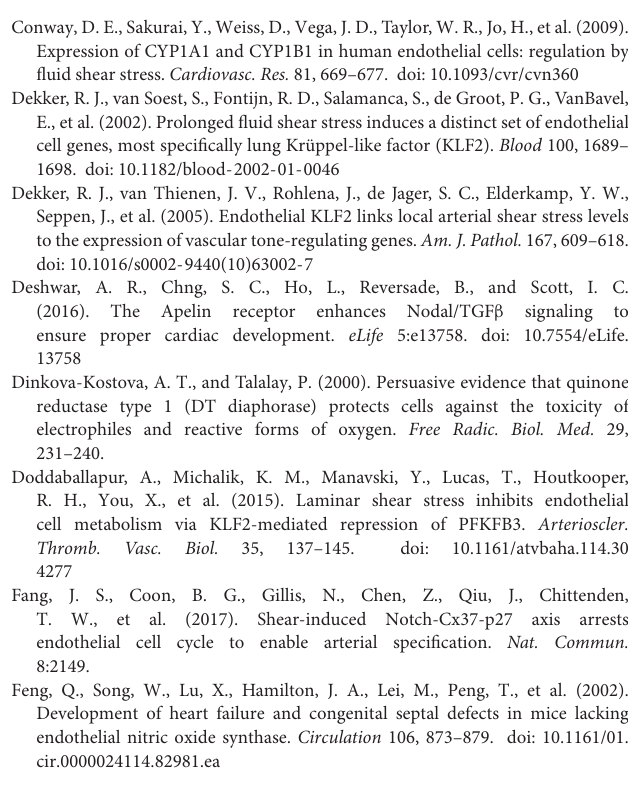
Supplementary Figure 1 | Characterization of single-cell RNA sequencing clusters in HEL24.3 cells. (A) UMAP (Uniform Manifold Approximation and Projection) plot of flow and static cells. (B) UMAP plot of the delineated clusters. (C) Dot plot of the marker genes in delineated clusters. (D) Feature plot of blood ( PECAM1, CDH5 ) and lymphatic ( PROX1, PDPN ) EC marker gene expression. (E) Violin plot of EC marker genes in all identified clusters. Supplementary Figure 2 | The expression of venous and arterial genes in hiPSC-EC flow and static clusters (HEL24.3). (A) Venous genes. (B) Arterial genes. Supplementary Figure 3 | The effect of flow on hiPSC-EC gene expression (HEL24.3). (A) Selected genes upregulated by the exposure to flow. (B) Genes downregulated in response to flow. Supplementary Figure 4 | NOTCH and VEGF pathway gene expression in scRNASeq (HEL24.3). (A) NOTCH pathway genes expressed in flow and static clusters. (B) VEGF pathway genes expressed in flow and static clusters. Supplementary Table 1 | List of differentially expressed genes upon flow exposure in (A) bulk RNASeq data, (B) scRNASeq data and (C) in combined analysis of bulk and single-cell RNASeq